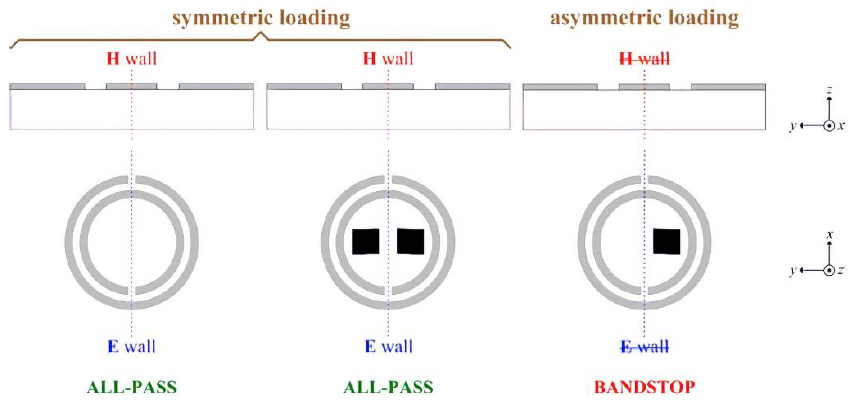
Figure 12. Illustration of symmetry disruption by means of square-shaped inclusions in a CPW loaded with a SRR. From [47], reprinted with permission.